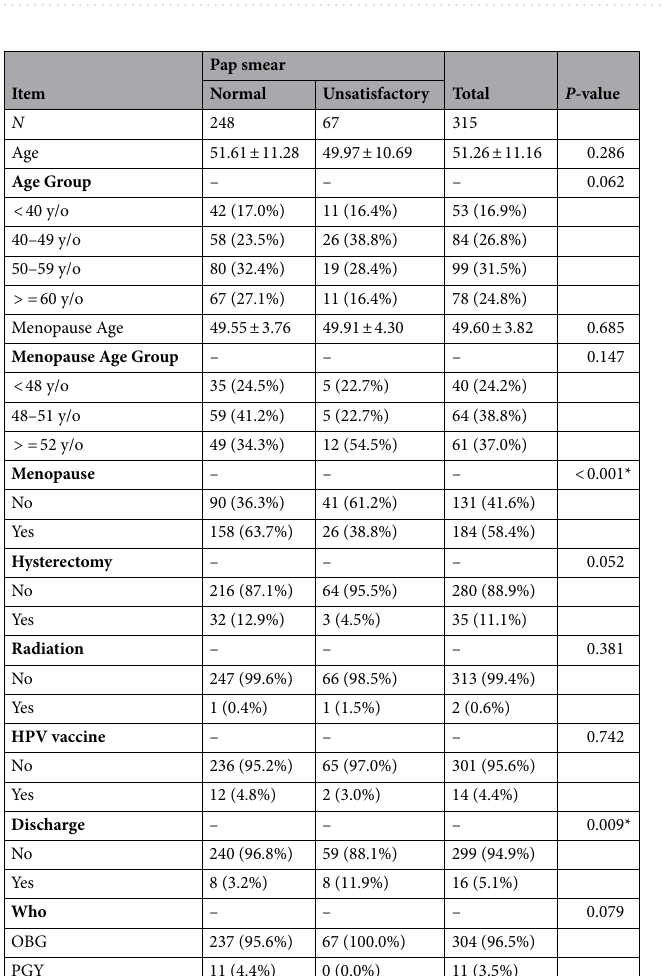
Figure 1. Flowchart of the study.